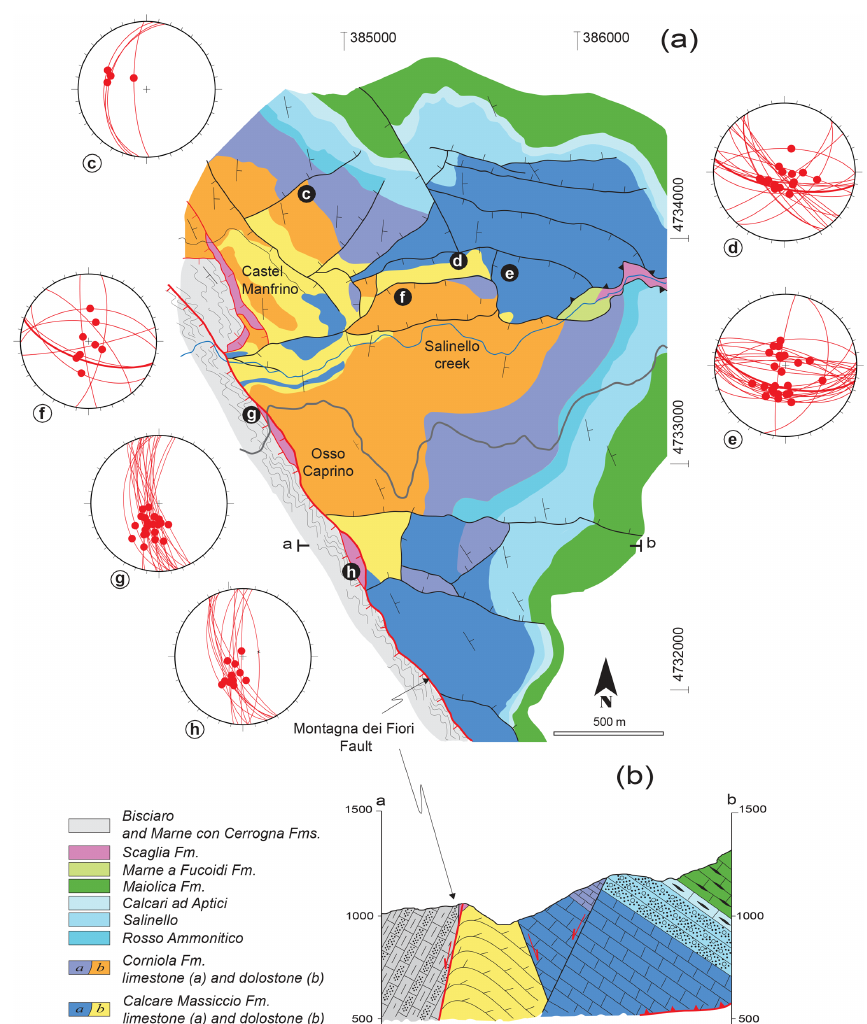
Figure 2. (a, b) Geological map of the central sector of the Montagna dei Fiori Anticline and cross section oriented parallel (a–b) to the hinge line representing the tectonostratigraphic architecture of the faulted anticline (modified after Storti et al., 2017a). The stereonets (Schmidt equal area projection lower hemisphere) provide the attitude of the extensional faults. The locations of the corresponding field sites are indicated by letters. (c) At this location, well exposed N–S-striking extensional fault zones offset the dolomitized Corniola Formation. The fault zone is characterized by near-horizontal stylolites localized in the footwall damage zone (4 fault data). (d, e, and f) These locations consist of mostly ∼ E–W-striking extensional fault zones. Particularly the boundary fault zones delimiting Calcare Massiccio Formation in the main horst block is evident (site d: 20 fault data; site e: 24 fault data; site f: 9 fault data). (g and h) At these locations, dip-slip slickenlines support major extensional movements related to the Montagna dei Fiori Fault. Contractional deformation structures are preserved in the bed-perpendicular stylolites, shear surfaces, and tension gashes arranged as S–C arrays (site g: 21 fault data; site h: 14 fault data). Equal area projection, lower